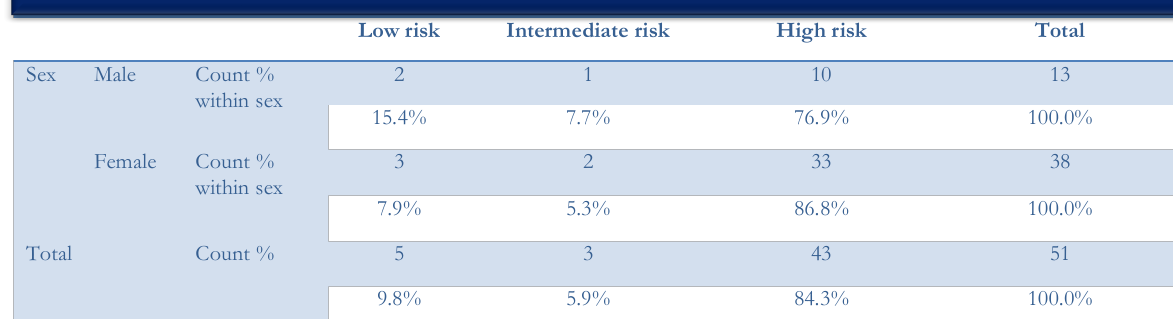
Table 2: Pattern of atherogenic index (Log10